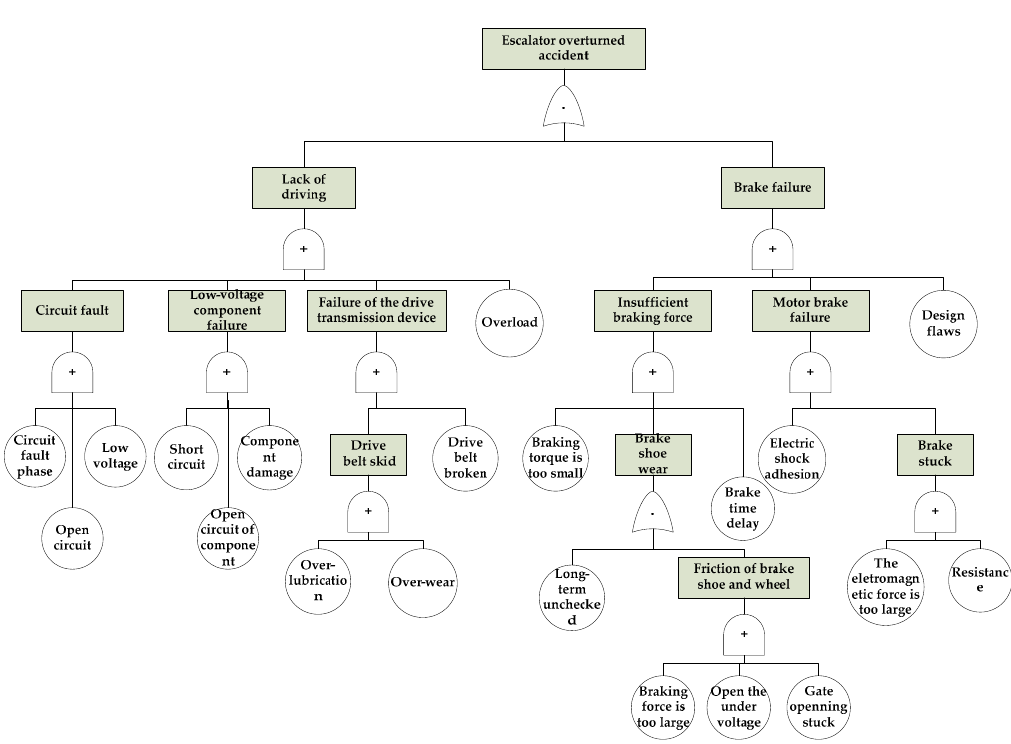
Figure 14. Fault tree of escalator overturned accident.